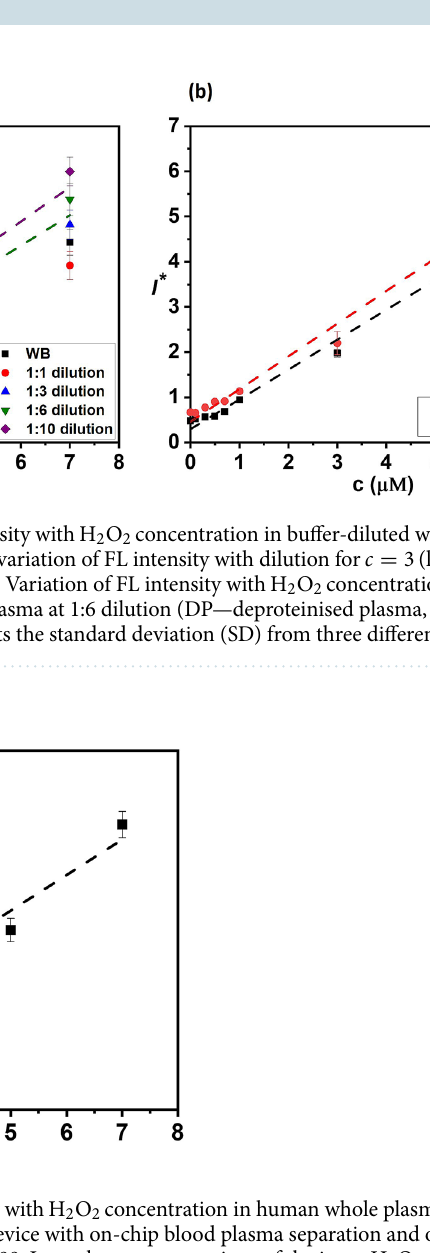
healthy volunteers are diluted with buffer at a 1:2 dilution ratio and infused into the microchannel at a flow rate of 20 μL min −1 to obtain a plasma flow rate of 1.0 μL min −1 . The remaining four-fold dilution of the plasma is obtained on-chip by maintaining the flow rates shown in Table S1 to achieve a final 1:6 dilution. The H 2 O 2 stock , at a flow rate 0–2.8 μL min −1 , buffer at a flow rate 2.8–0 μL min −1 and plasma at a fixed flow rate of 1.0 μL min −1 was infused into the device to obtain exogenous H 2 O 2 concentration in the range of 0–7 µM. The H 2 O 2 in plasma is then mixed and incubated with the probe infused into the device at a fixed flow rate of 0.2 μL min −1 in the serpentine channel for 15 min before entering the detection module. The variation of FL intensity with the concentration of exogenous H 2 O 2 in plasma measured using the integrated device is depicted in Fig. 5. A linear increase in the FL intensity with the plasma H 2 O 2 concentration is observed, I ∗ = 0.60 c + 0.37 (with R 2 = 0.98 ). The calibration obtained from the data presented in Fig. 4b is used to predict the concentration of H 2 O 2 in plasma and is compared against the actual exogenous concentration of H 2 O 2 , as shown in the inset of Fig. 5. The curve is linear with a slope ≈ 1 and a very good match (within 2%) between the predicted and actual H 2 O 2 concentration is obtained indicating that the integrated device can accurately measure the concentration of H 2 O 2 in plasma. Considering the 1:6 dilution, the limit of detection of the device and assay is found to be 0.05 µM, and sensitivity is found to be 0.60 µM −1 (See the Section S5 in “Supplementary Material” and Fig. S4 for a zoomed view in the concentration range 0–1 µM).